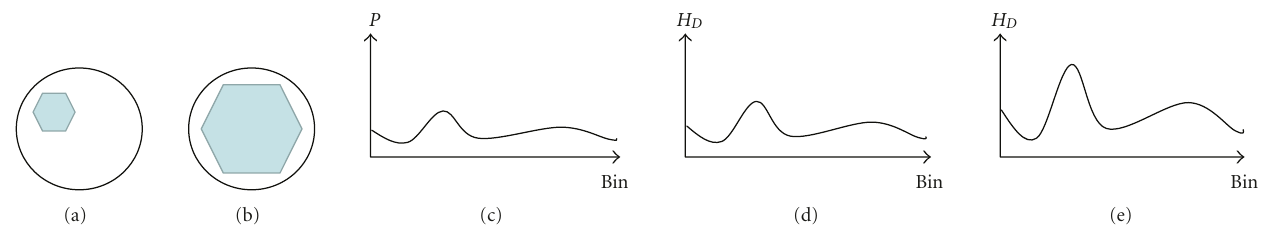
Figure 3: (a), (b) Two circular regions with the same content at di ff erent resolutions. (c) Same pdf for the regions (a) and (b). (d) Orientations histogram for (a), and (e) orientations histogram for